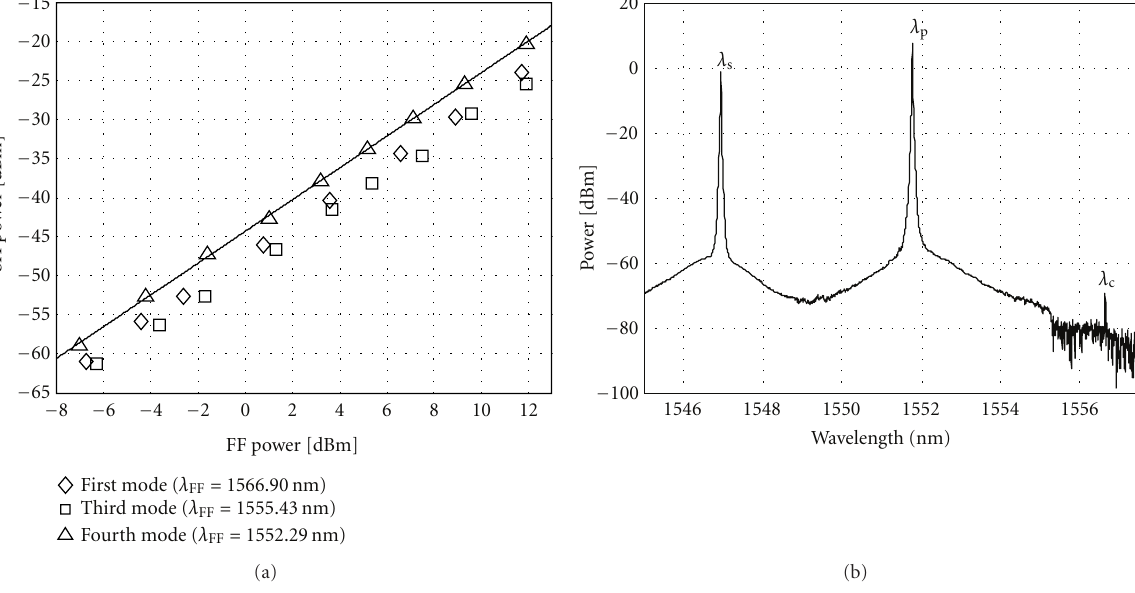
Figure 12: (a) SH power versus FF power at three QPM resonances in a log scale (symbols); the solid line is best fit for the most e ffi cient SH interaction. (b) Spectral conversion in single-pass